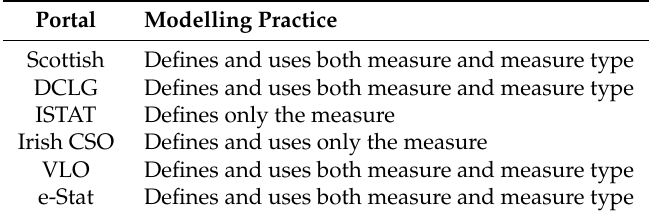
Table 18. Modelling practices of data portals for the measure and its